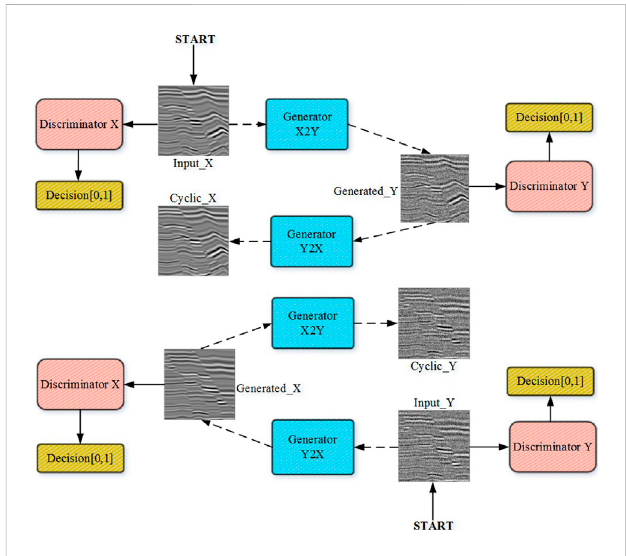
FIGURE 2 Working principle of